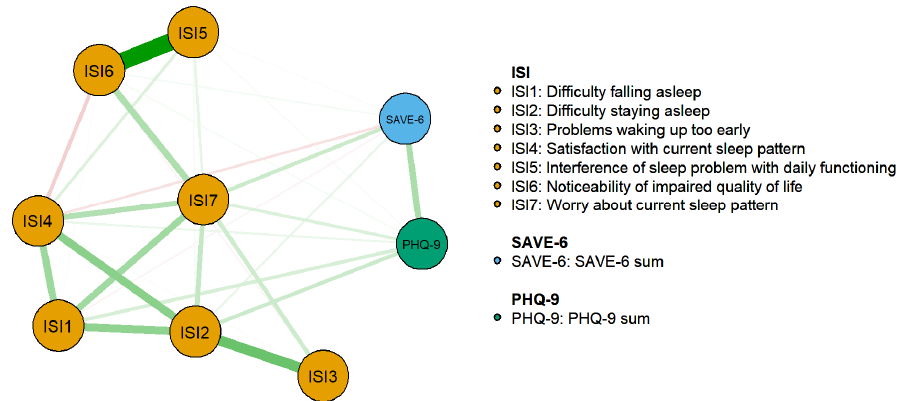
Figure 1. Network structure of insomnia symptoms, stress response to COVID-19, and depression level in a non-infected general population.